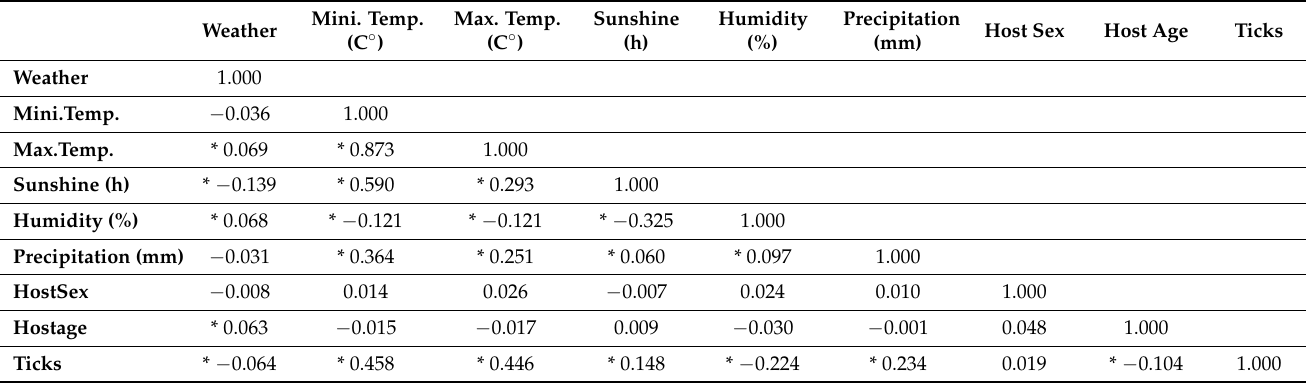
Table 3. Correlation between different parameters and their effects on prevalence of ticks (n = 1500).